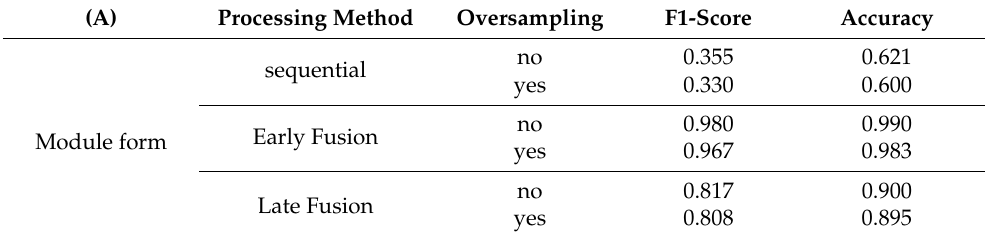
Table 1. F1-scores compared by classification approach without oversampling.